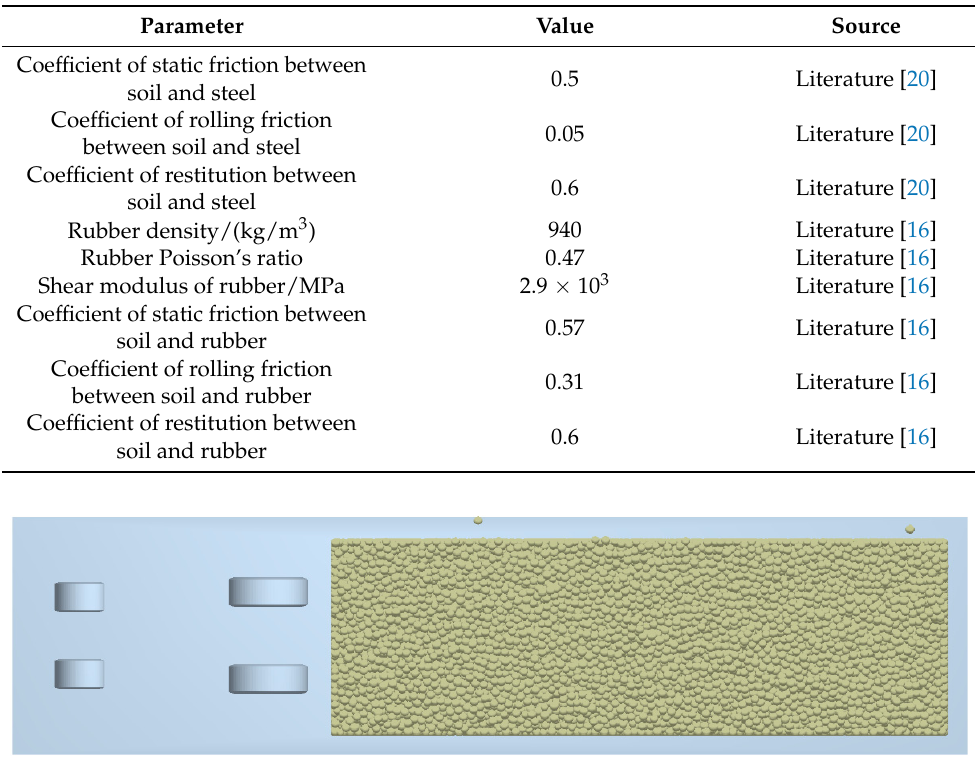
Figure 3. Soil simulation simplified model.